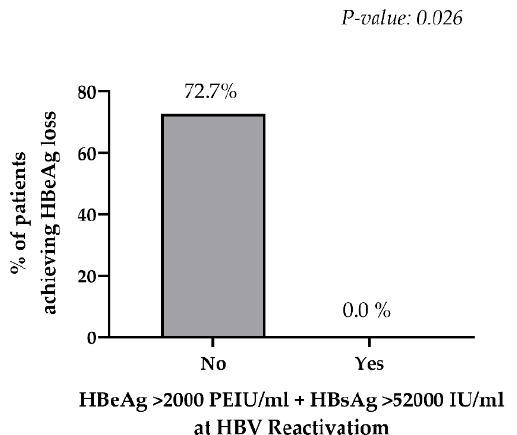
Figure 2. Distribution of HBeAg levels in patients stratified according to serum HBV ‐ DNA in patients with acute HBV infection and immunosuppression ‐ driven HBV reactivation. Boxplots report median, 25th and 75th percentile, min and max values of qHBeAg (expressed in PEIU/mL) in patients with acute infection ( A ) stratified according to serum HBV ‐ DNA lower or higher than 8 logIU/mL and in patients experiencing immunosuppression ‐ driven HBV reactivation ( B ) stratified according to serum HBV ‐ DNA lower or higher than 5.5 logIU/mL. Statistically significant differences were as ‐ sessed by the Mann–Whitney test.